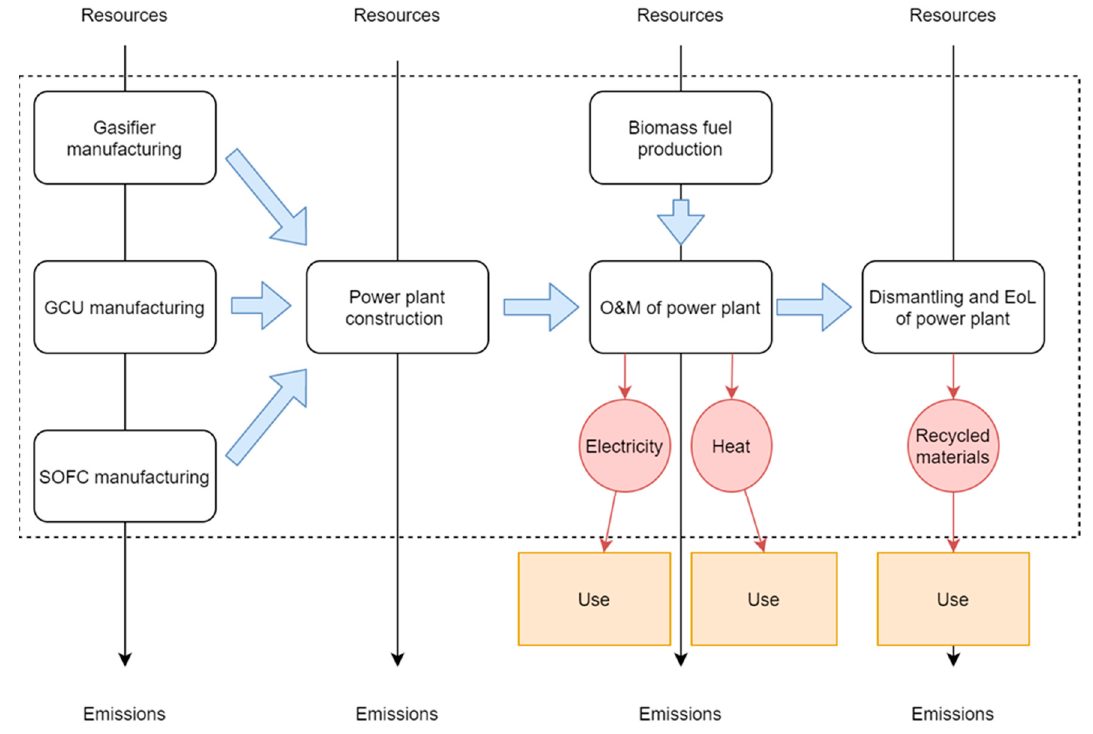
Figure 2. Flowchart of the HBP product system, including system boundaries (dashed lines).